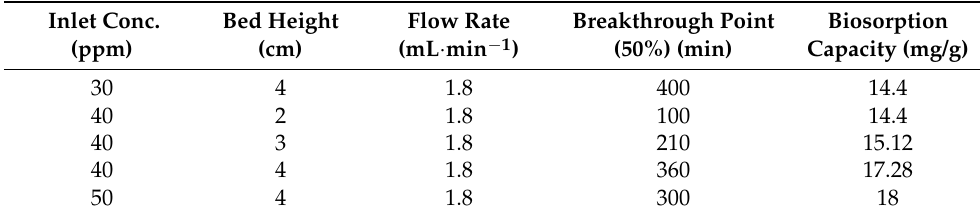
Table 4. Breakthrough point and capacities at various conditions for 2,4,6-TCP uptake by FeCl 3 - NaBH 4 /MS hybrid